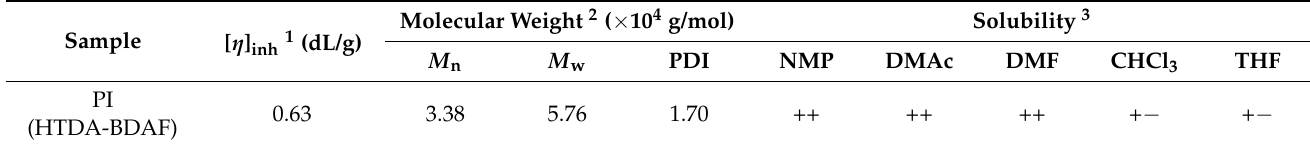
Table 2. Inherent viscosities, molecular weights, and solubility of PI resins.